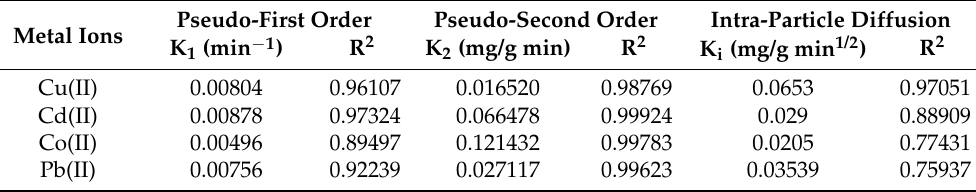
Table 2. Dynamic parameters for the adsorption of metal ions on MXCS/PAA.